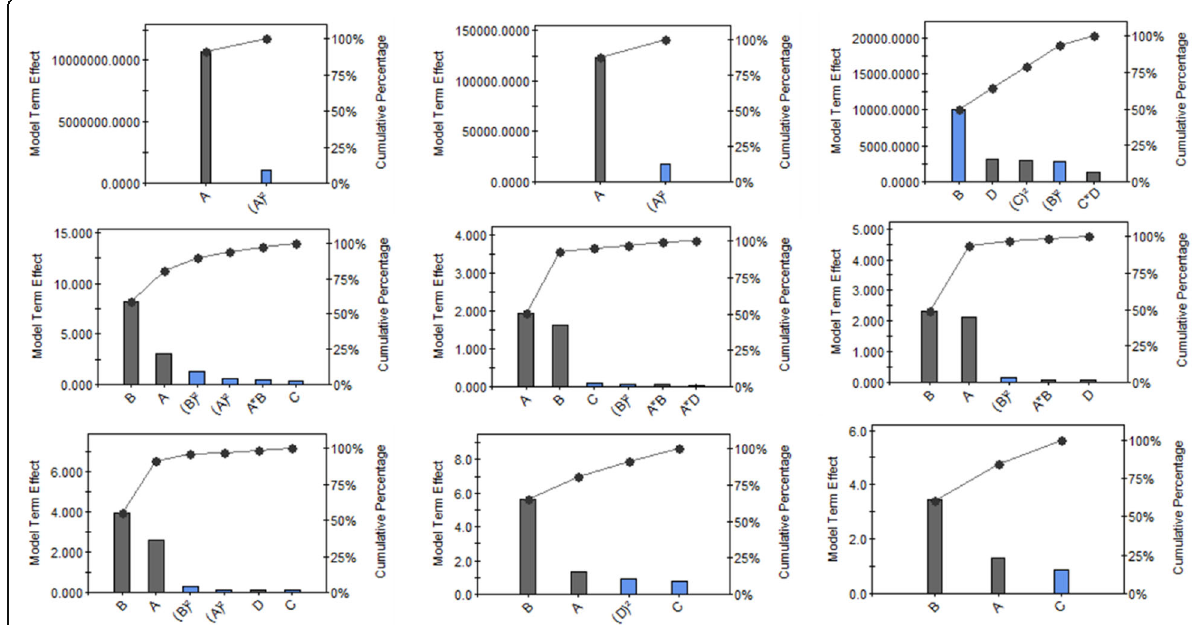
Fig. 2 Model Term Ranking Pareto Charts. Top row from left to right: API area (default), Epimer area (default), API plate count. Middle row from left to right: API RT, Epimer RT, Impurity 2 RT. Bottom row from left to right: impurity 3 RT, # of peaks, # of peaks with ≥ 1.5 —